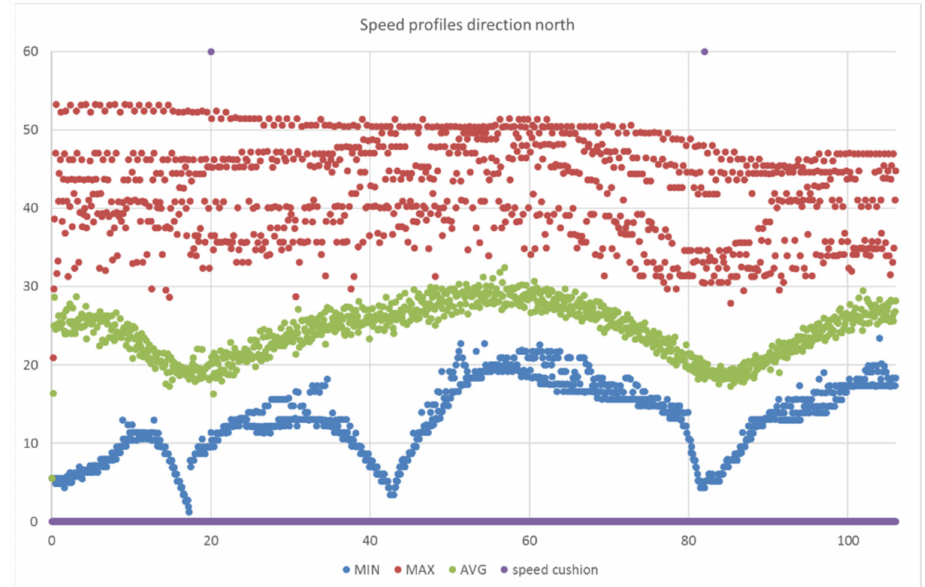
Figure 7. Speed profile for Stachiewicza street, direction northbound (source: